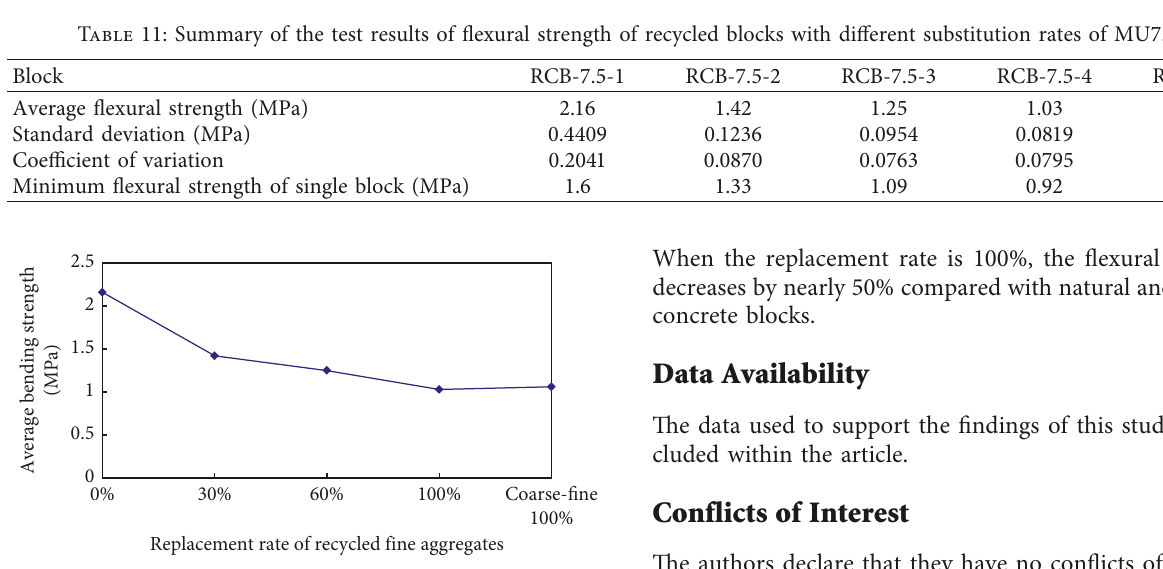
Figure 12: Flexural strength curve of the recycled fine aggregate with different substitution